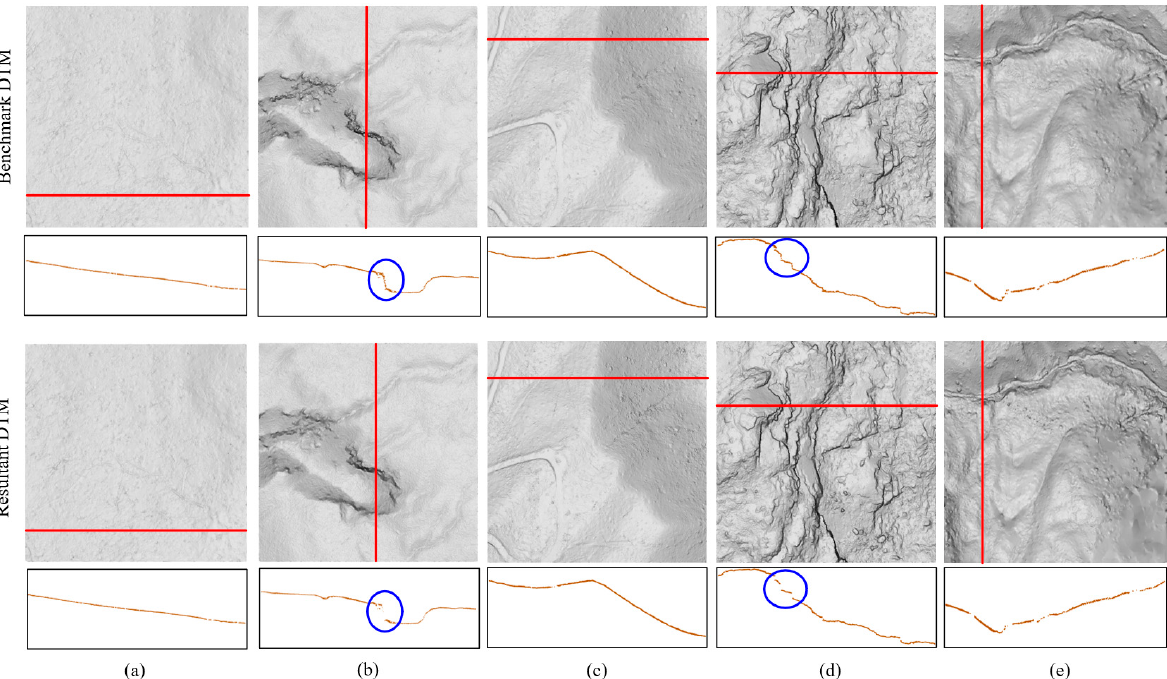
Figure 8. DTMs of the proposed method in all sites: ( a ) Site 1, ( b ) Site 2, ( c ) Site 3, ( d ) Site 4 and ( e ) Site 5. The red lines indicate the positions of cross sections, and the content inside the blue ellipses is the terrain details ignored by the proposed method. Table 4. Errors and kappa coefficients of the proposed method in all sites (%).